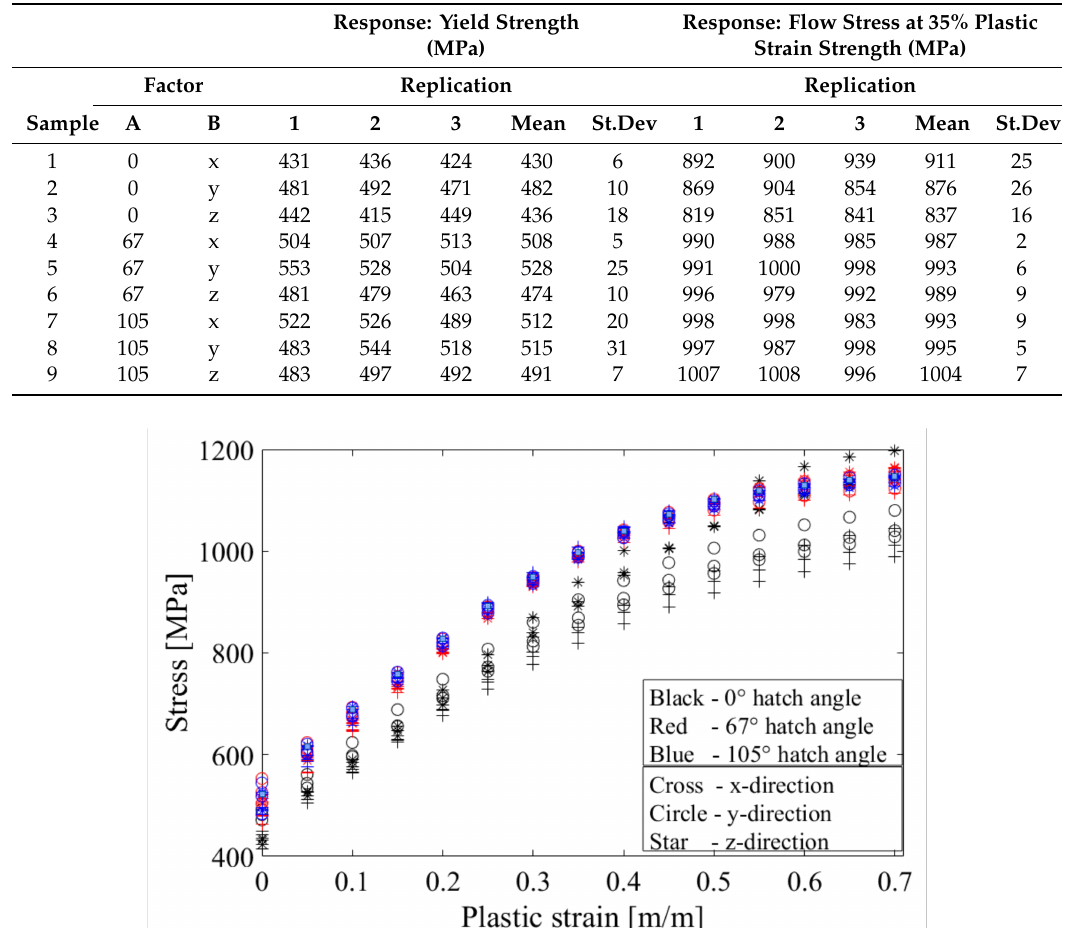
Table 6. Full factorial design of the two control factors with three replicates.